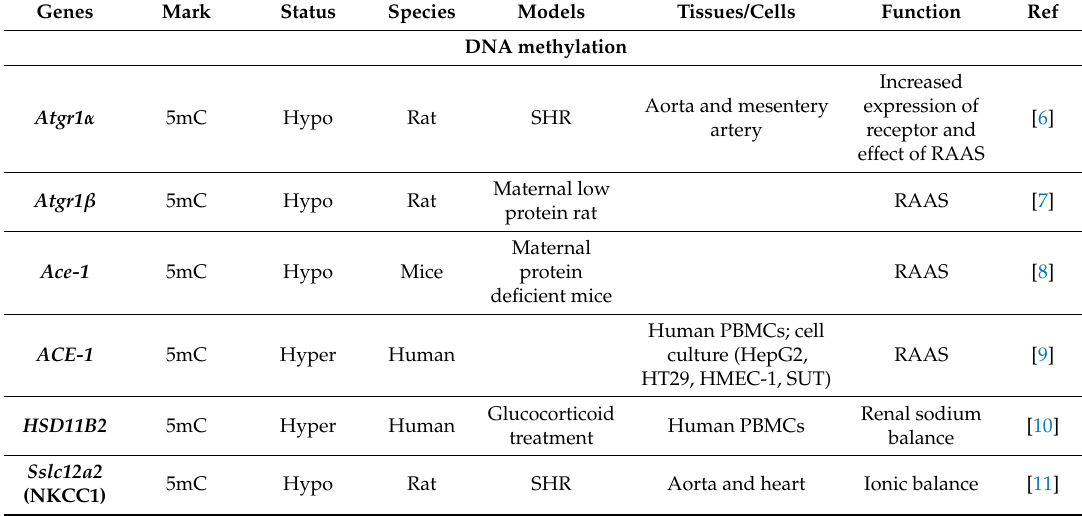
Table 1. DNA methylation and histone modification associated with